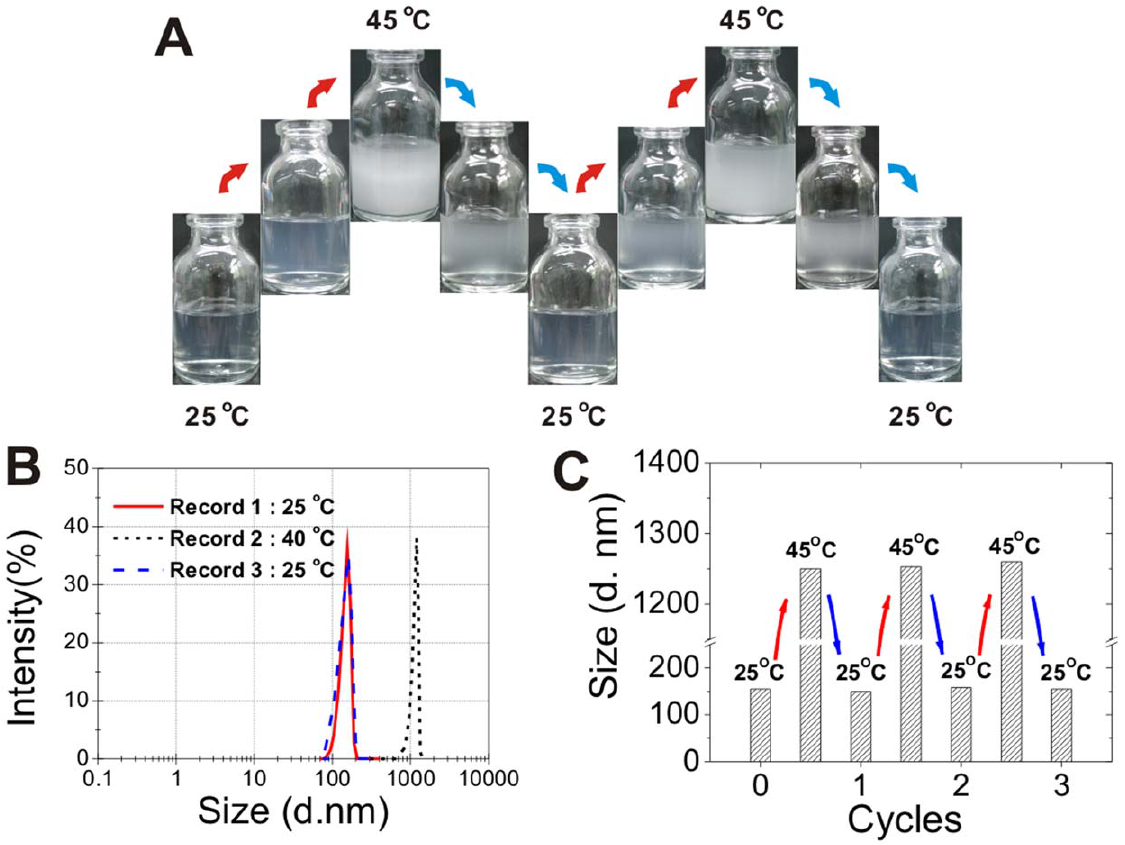
Figure 2. Temperature responses effect of CLGNs. (A) Pictures of CLGNs at different temperatures. (B) Size distribution of CLGNs at different temperatures measured using DLS. (C) Size changes of CLGNs at 25 u C and 45 u C within three